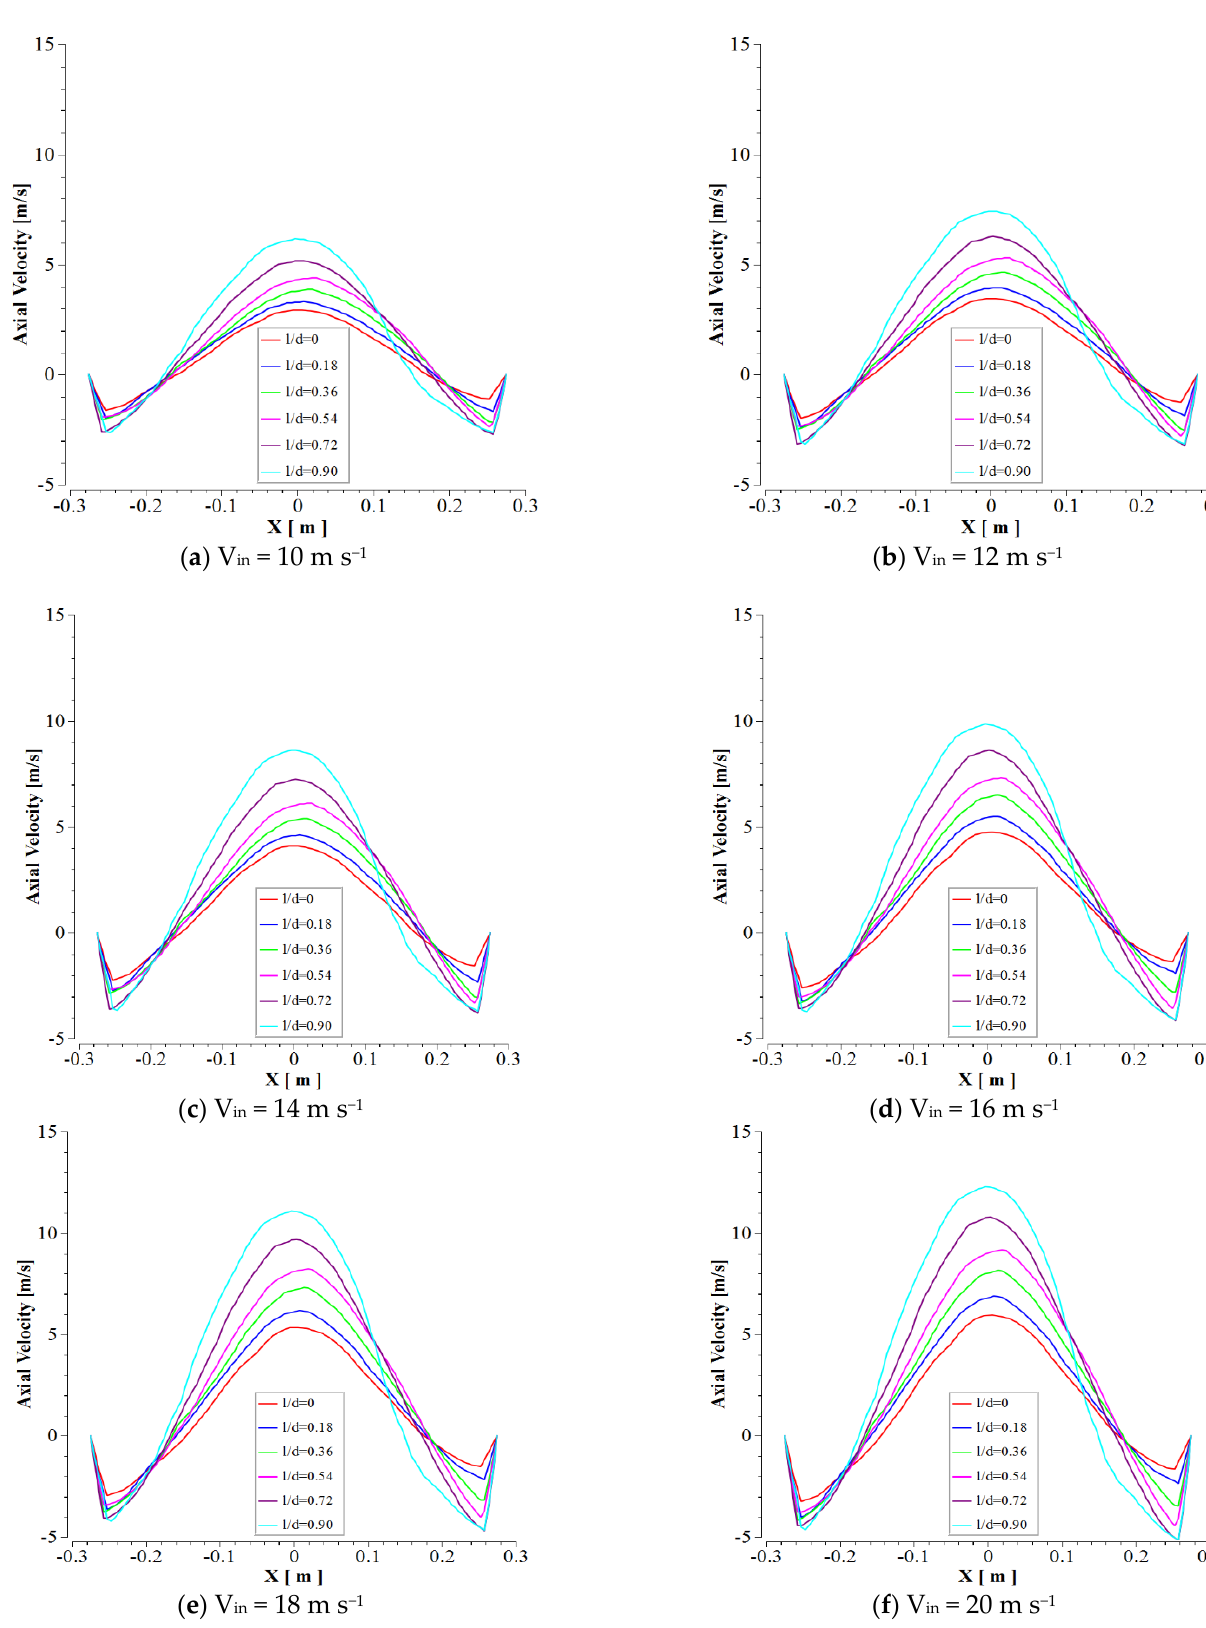
9 of 20 Figure 6. Axial velocity contours in various inlet velocities. An essential issue in the cyclone body is the variation of axial velocity in the x-direc- tion. As shown in Figure 7, the variations of axial velocity in several cyclone cylinder heights were presented. The plots indicate a decreasing–increasing treatment concerning axial velocity in various ratios of heights, so that from the wall to a small distance, the axial velocity was decreased and then dramatically increased to the maximum value in the center section of the cyclone. On the positive side of the axial axis, the treatment re-